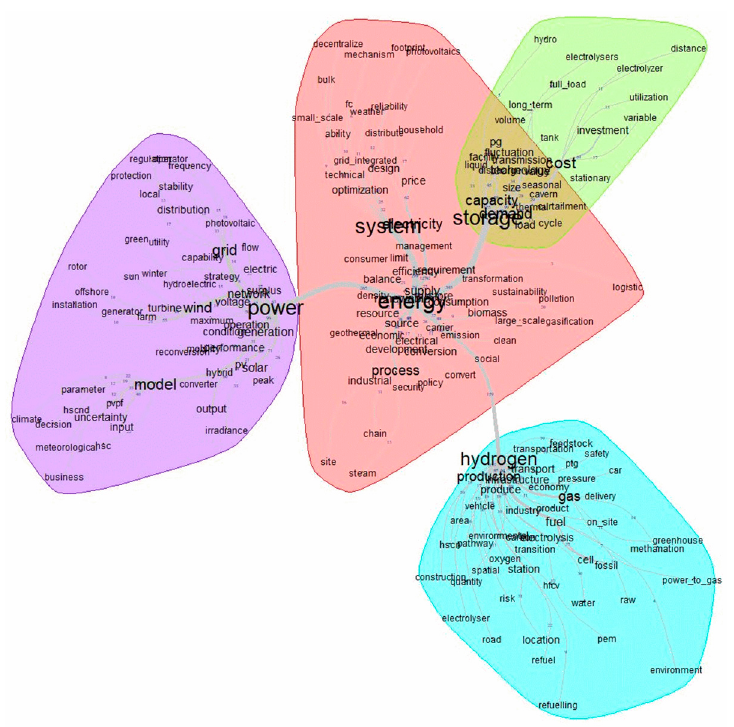
Figure 8. The results of the similarity analysis of the selected 189 words. Source: Own elaboration based on the analysis in the IRAMUTEQ software.